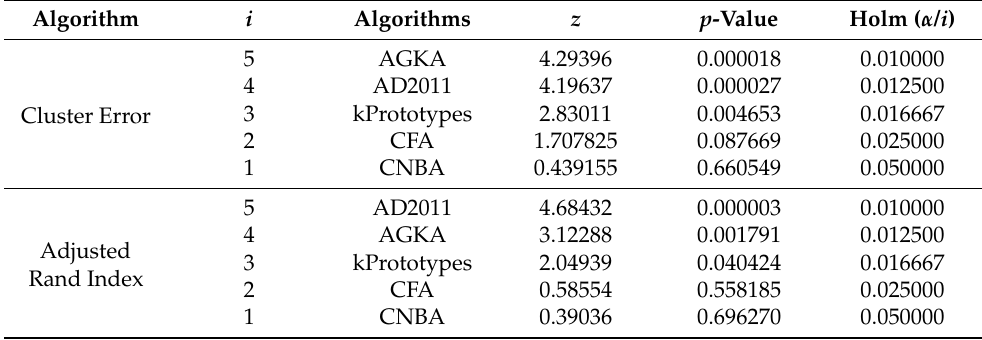
Table 10. Results of the Holm test comparing the best performed algorithm with respect others, according to the cluster error and ARI